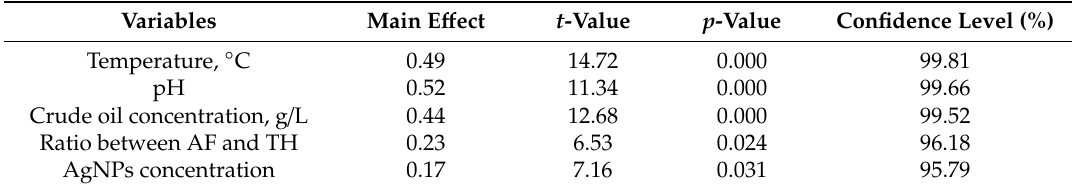
Table 6. Estimated regression coefficients for optimization of biodegradation efficiency using Box-Behnken design.